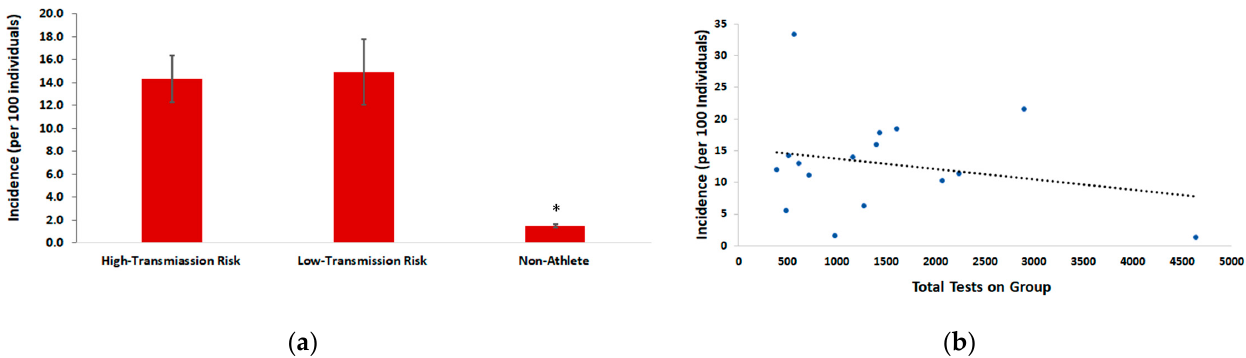
Figure 2. Incidence of COVID-19 infection of high-transmission risk athletes, low-transmission risk athletes, and non-athletes during the 2020/2021 academic year at Gannon University, Erie campus. ( a ) Incidence of COVID-19 infection of athlete group (high-transmission risk or low-transmission risk as classified in Table 2) and non-athletes. Values represent average incidence per 100 individuals of groups represented in Table 2. Error bars are the standard error. *Denotes a p -value below 0.02 using a two-tailed Student’s t-test when comparing average value of non-athletes to high-risk or low-risk of COVID-19 transmission athletes. ( b ) Linear regression of average incidence of COVID-19 infection for groups represented in Table 2 compared with total COVID-19 tests performed on that group.